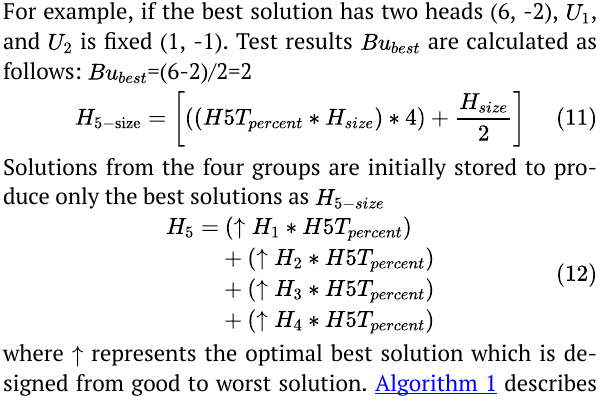
u values are calculated using (4), (5), r and u to calculate perception and visibility. However, in cases 3, 4 and 5, r is set to 1 and in cases 1 and 2, u is adjusted to